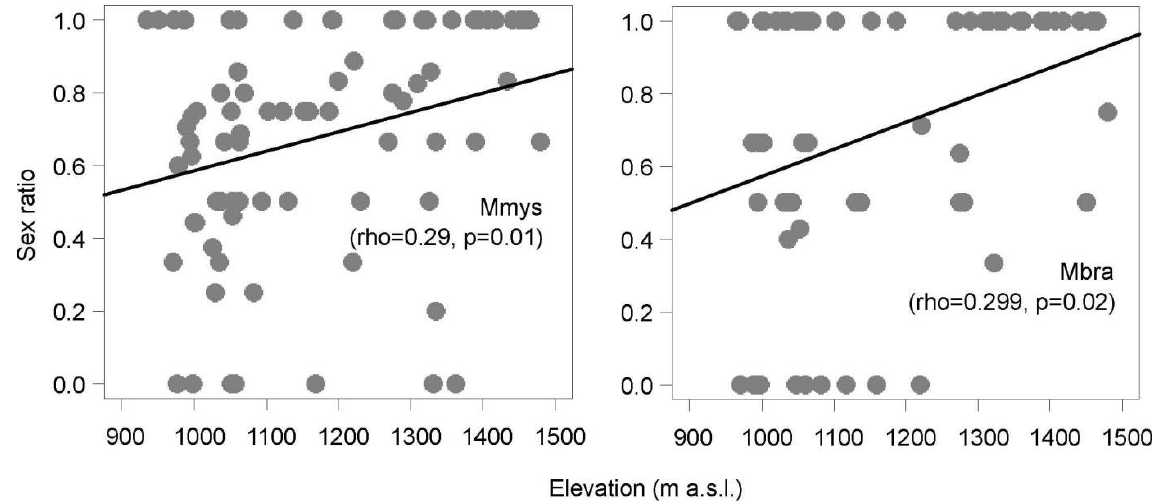
Figure 10. Changes in the sex ratio of M. mystacinus (Mmys) and M. brandtii (Mbra) along the elevation gradient in the forest of the Polish Tatra Mountains, 2016 – 2020.